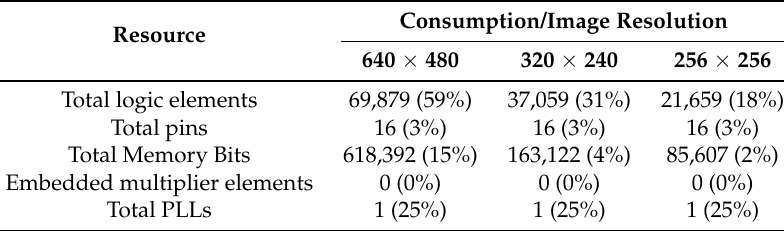
Table 1. Hardware resource consumption for the developed FPGA architecture.